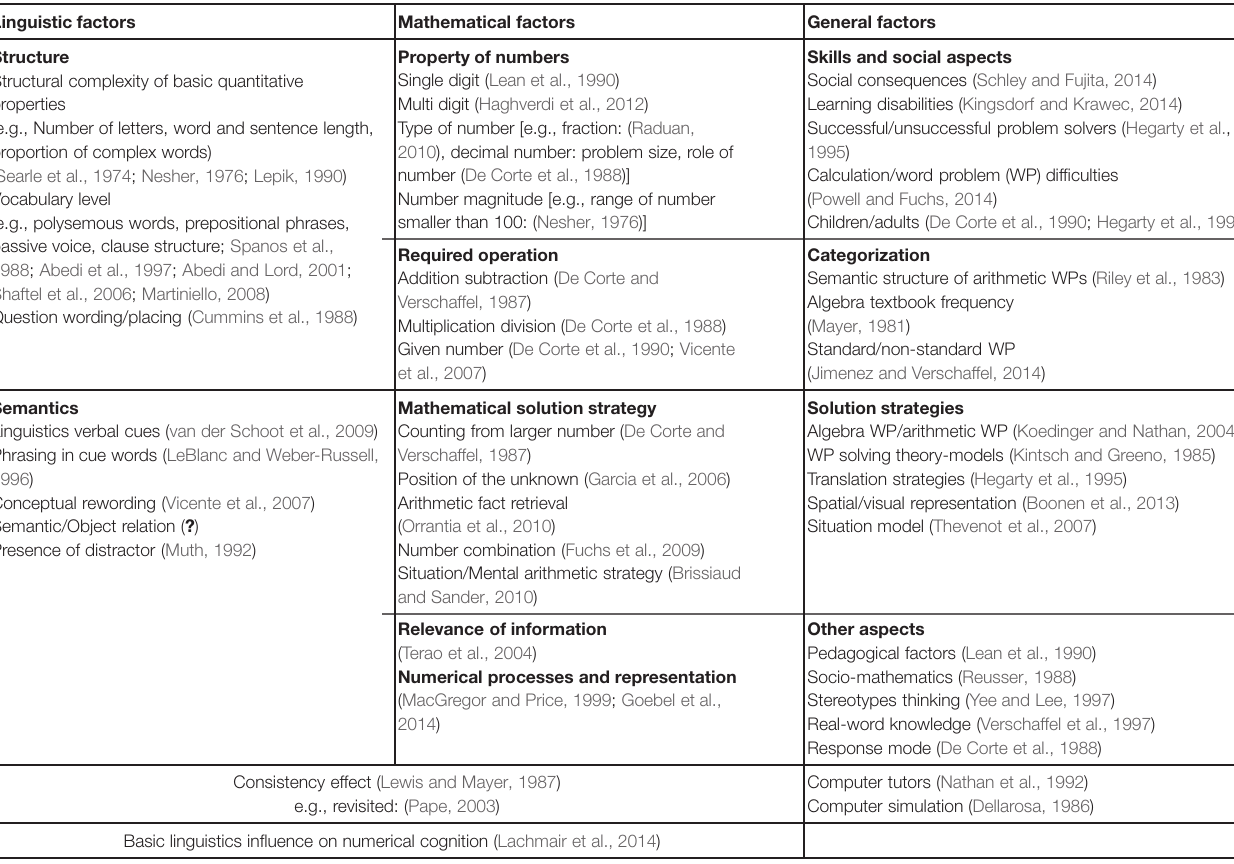
TABLE 1 | Selected linguistic, mathematical, and general factors investigated in previous